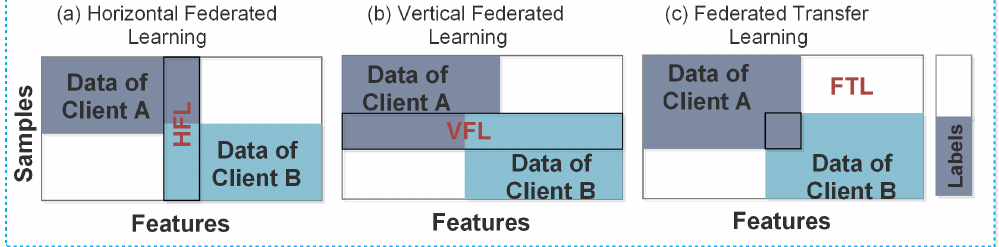
Figure 2. Classification of federated